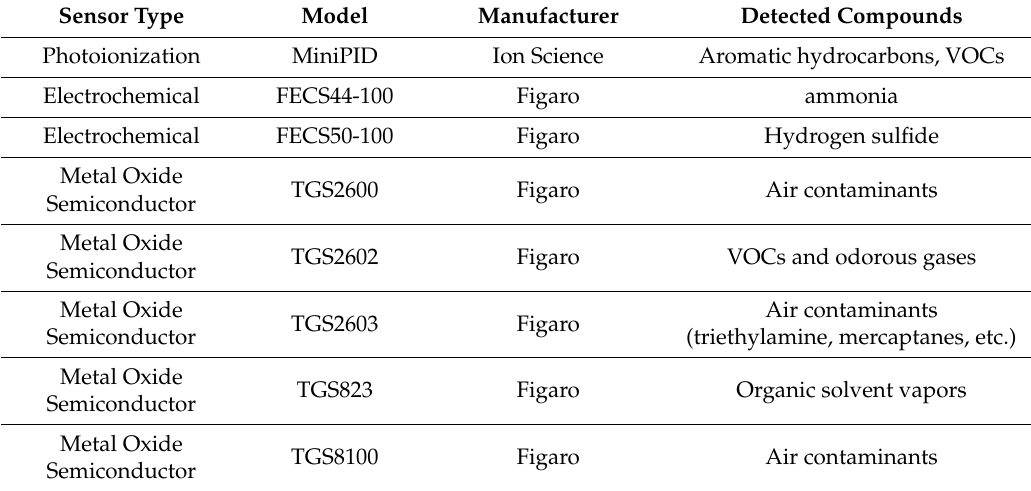
Table 3. Types of chemical sensors used in electronic nose prototype.